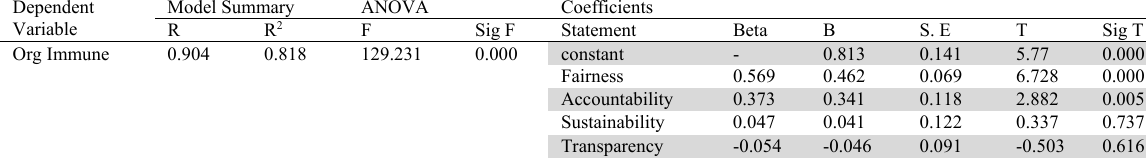
Results of a multiple regression analysis of the effect of governance on organizational immunity Dependent